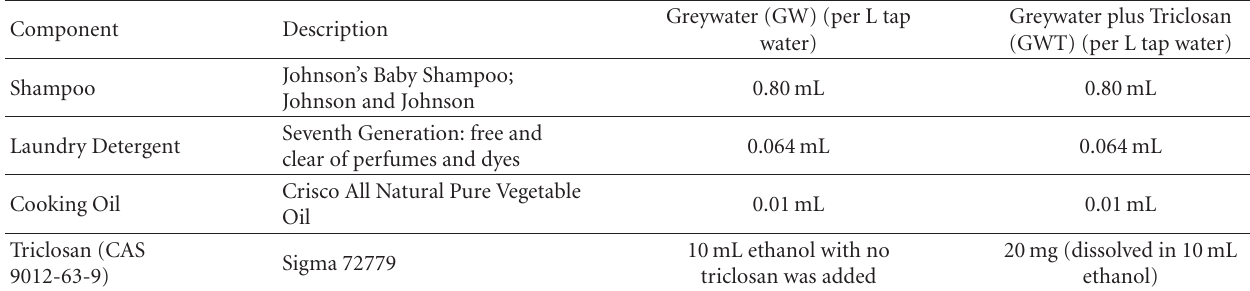
Table 1: Composition of Synthetic Greywater Used in this Research.